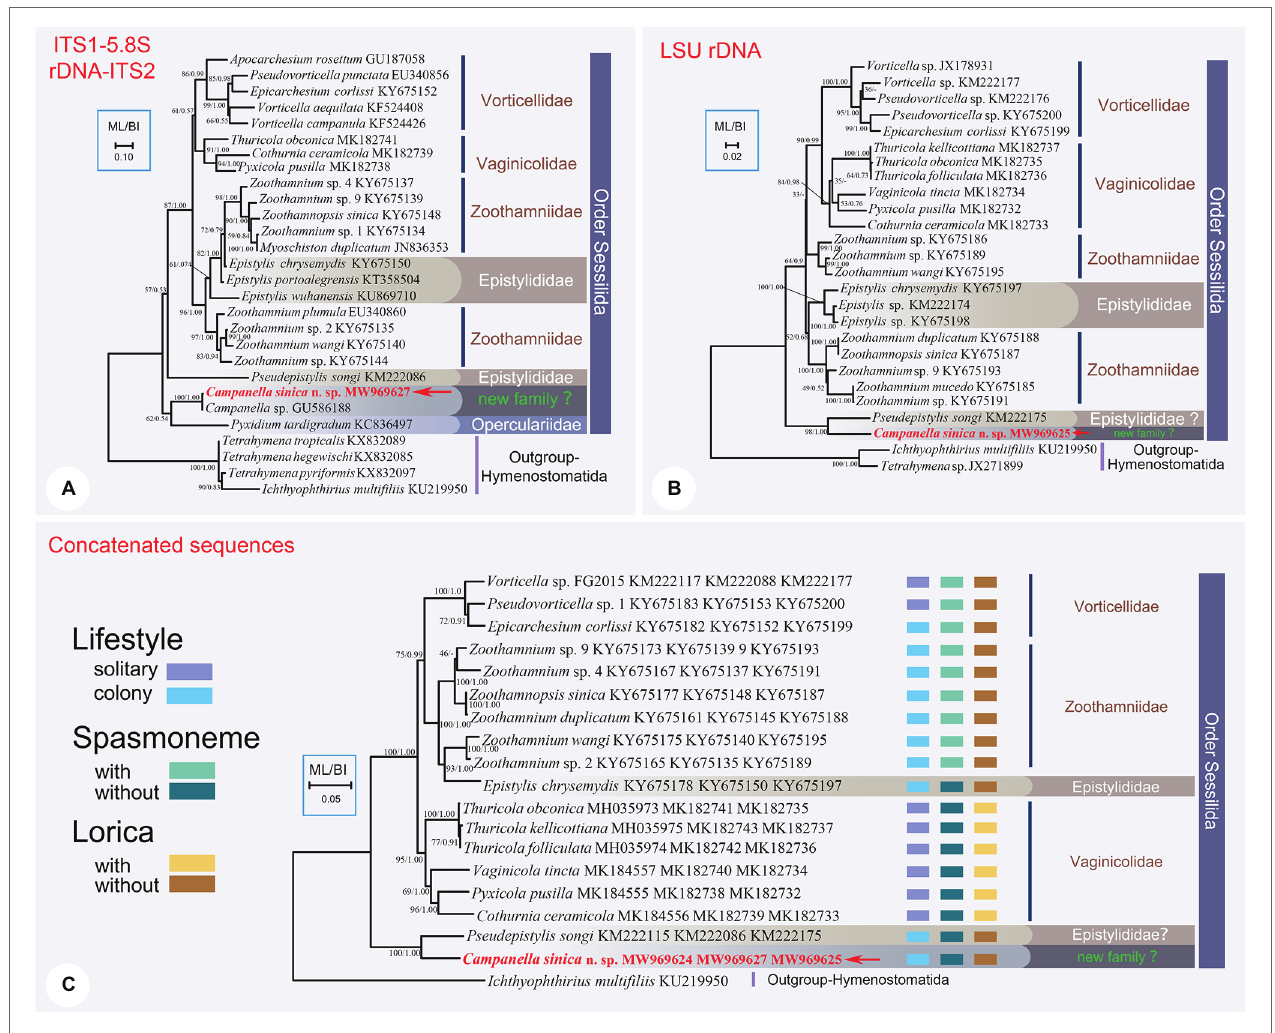
FIGURE 2 | The ML trees inferred by ITS1-5.8S rDNA-ITS2 region (A) , LSU rDNA sequence (B) , and the concatenated data of SSU rDNA, ITS1-5.8S rDNA-ITS2, and LSU rDNA sequences (C) . In each tree, Campanella sinica n. sp. is in red and indicated by an arrow. Numbers given at nodes of branches are the UF values for ML analysis and PP values for BI analysis. The scale bar corresponds to ten, two, and five substitutions per 100 nucleotide positions in (A-C) , respectively.